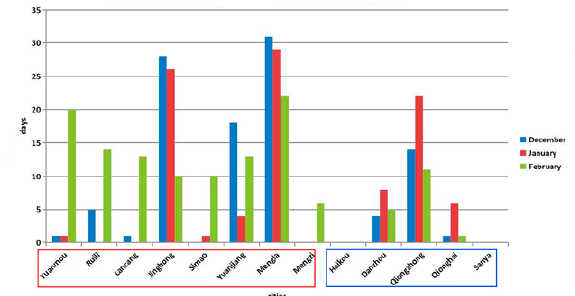
Figure 4. Temporal changes in CCI (left vertical axis; red line) and TCI (right vertical axis; green line) scores, Figure 5. Number of days classed by the CCI as Optimal hotel reception numbers (right vertical axis; black line; (CCI = 9) during December (blue), January (red), and unit: 10,000 people), the linear trend of hotel reception February (green) for eight cities in Yunnan (red rectangle: numbers (blue line), and anomalies in hotel reception Yuanmou, Ruili, Lancang, Jinghong, Simao, Yuanjiang, numbers after detrending (left vertical axis; blue bars) Mengla, and Mengzi) and five cities on Hainan (blue for winter (December, January and February) on Hainan rectangle: Haikou, Danzhou, Qiongzhong, Qionghai, and between 2002 and 2010